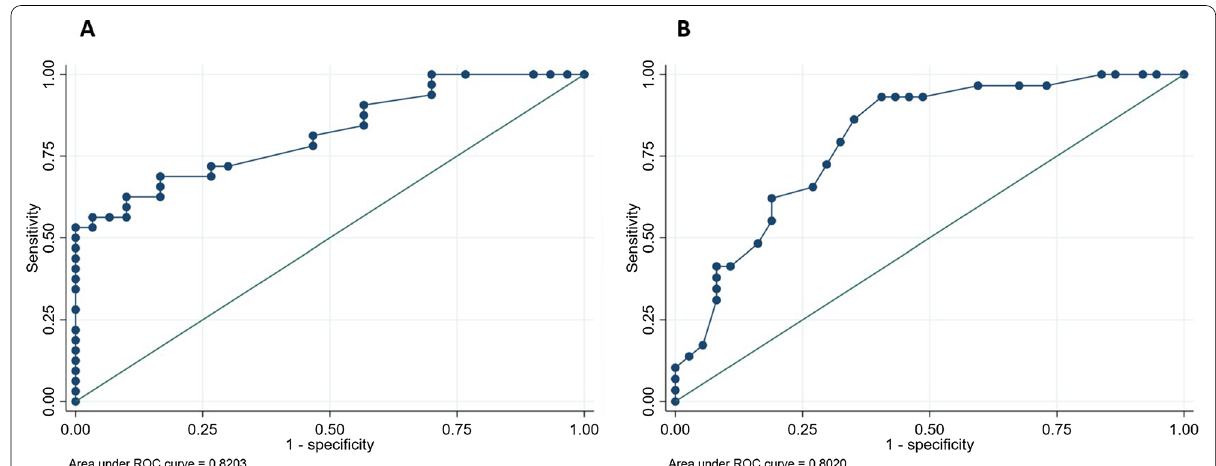
Fig. 2 A Receiver operating characteristic curve (ROC) of the spleen ECV % between those with AL amyloidosis and left ventricular hypertrophy due to aortic stenosis, B ROC curve of spleen STIR ratio between those with AL amyloidosis and left ventricular hypertrophy due to aortic